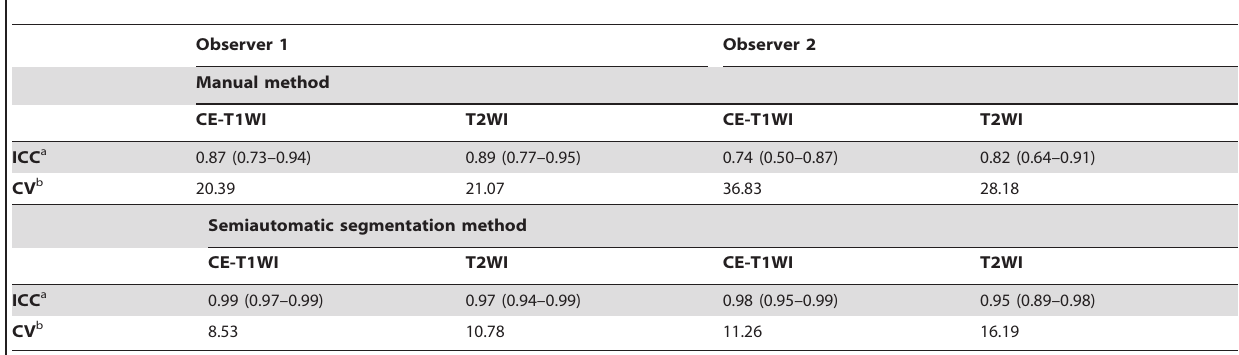
Table 2. Intraobserver reproducibility of nCBV